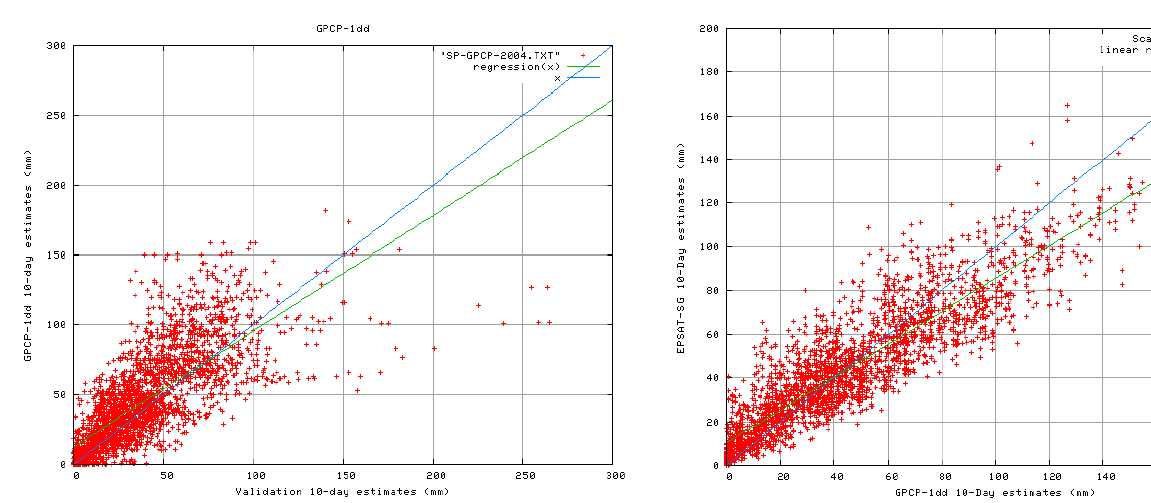
Figure 16.a. Scatter-plot of GPCP-1dd versus validation rain-gauge dataset. Fig. 16a. Scatter-plot of GPCP-1dd versus validation rain-gauge dataset.